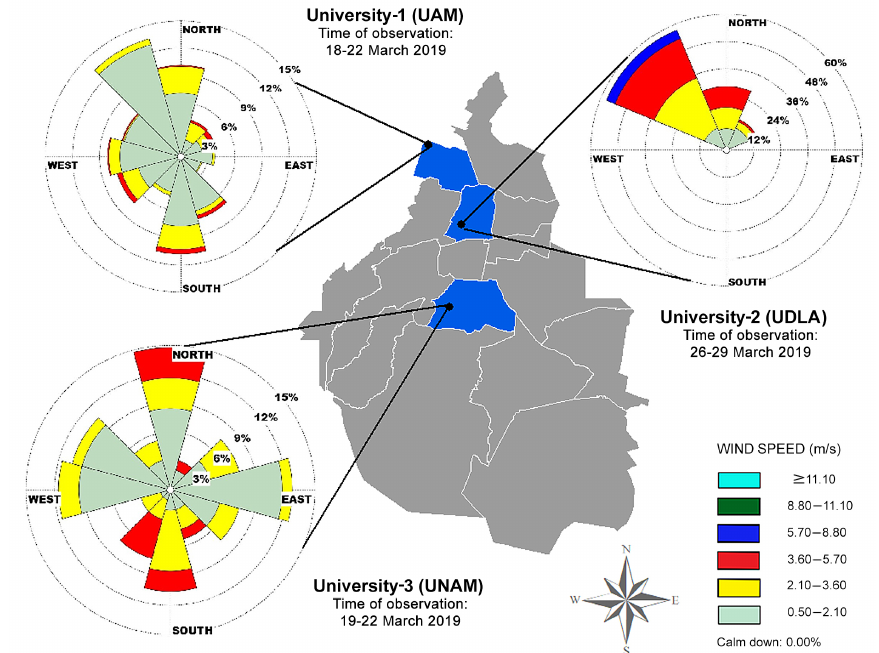
Figure 5. Spring sampling campaign wind roses: University-1 (UAM), University-2 (UDLA) and University-3 (UNAM).